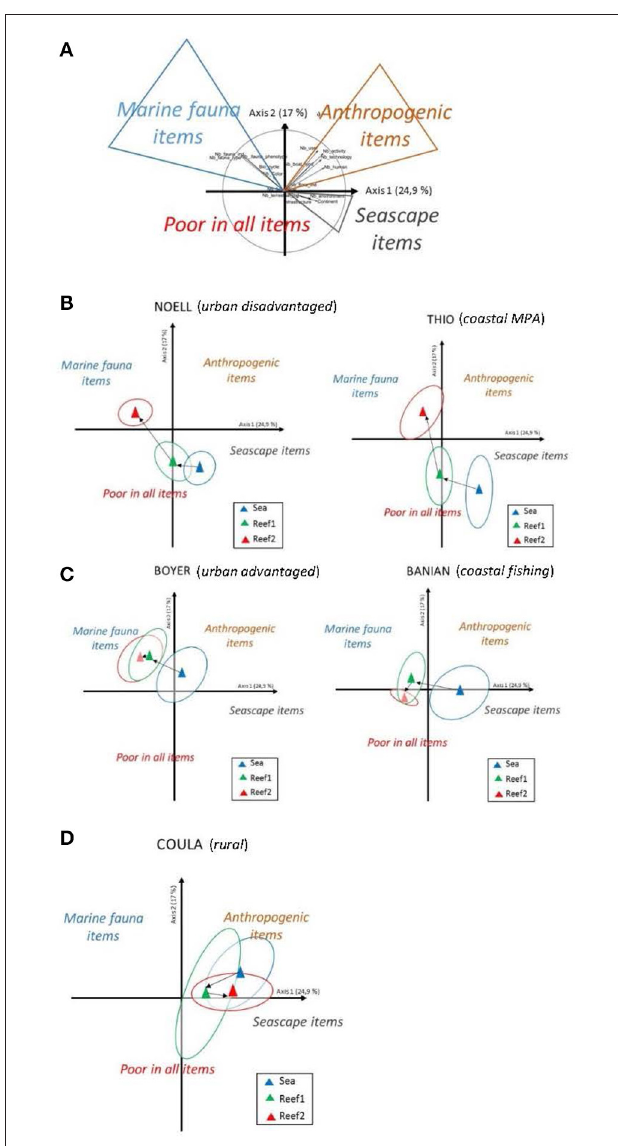
FIGURE 8 | Projection of the centers of gravity and confidence ellipses of the groups Themes*Schools on the first factorial plane of the PCA (blue: Sea; green: Reef1; red: Reef2). (A) Explanatory variables of the factorial axes 1 and 2. (B) Noell (disadvantaged school in urban neighborhood) and Thio (coastal school close to a marine reserve), (C) Boyer (socially-advantaged school in urban neighborhood) and Banian (coastal school near within a large fishing community), (D) Coula (rural